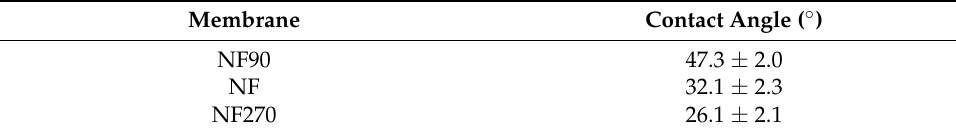
Table 4. Contact angle for investigated nanofiltration membranes.